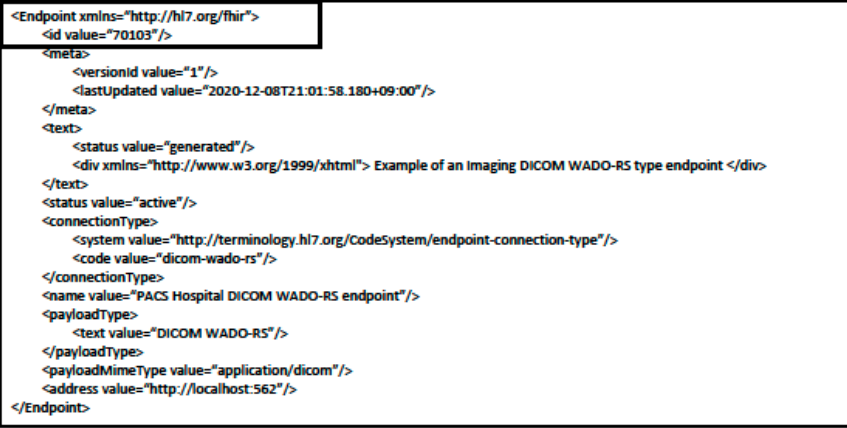
Figure 8. Example of Endpoint Resource XML Transmission Results.